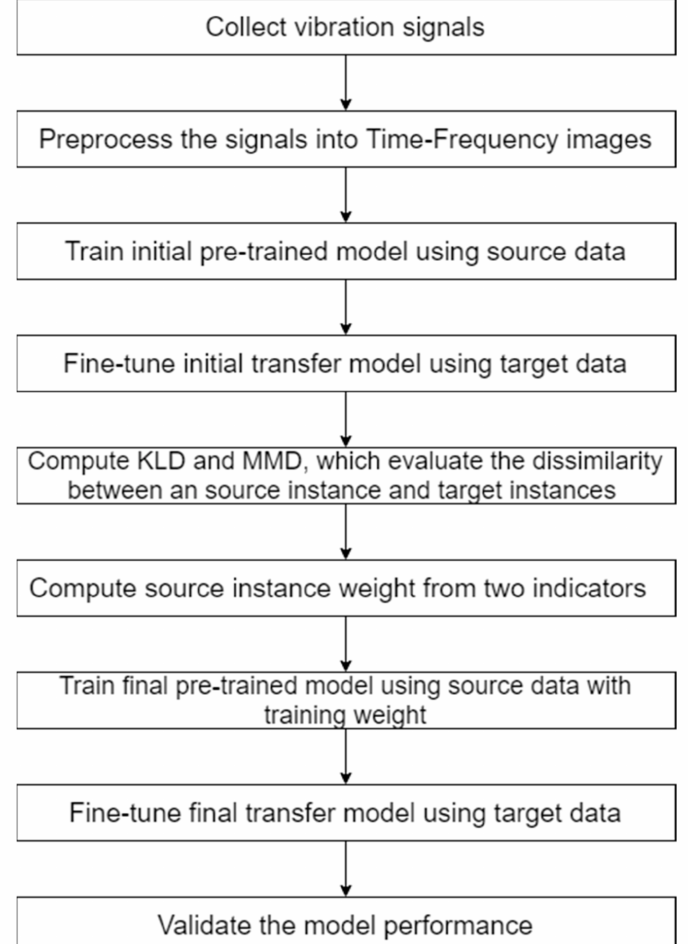
Figure 2. Flowchart of the proposed multi-objective instance weighting-based transfer learning network (MOTL)